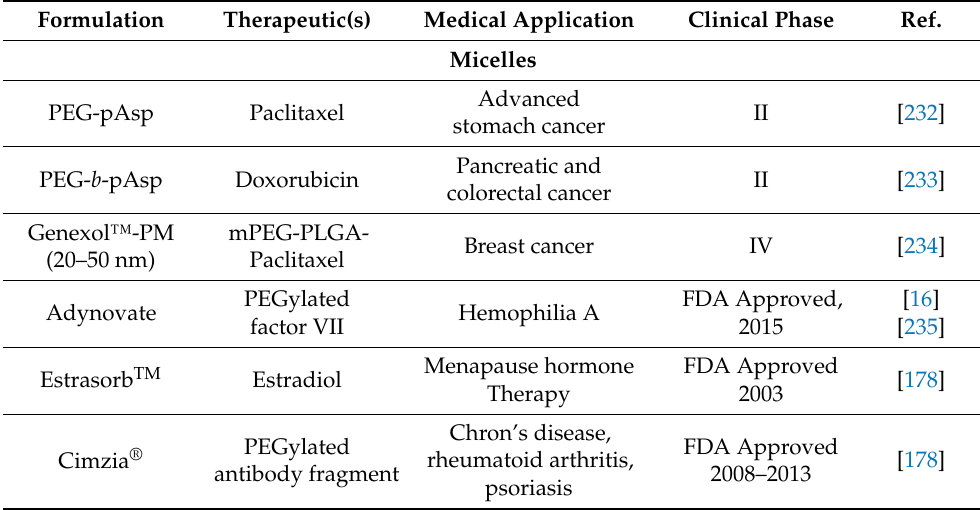
Table 3. Commercially-available products and clinical trials utilizing self-assembled